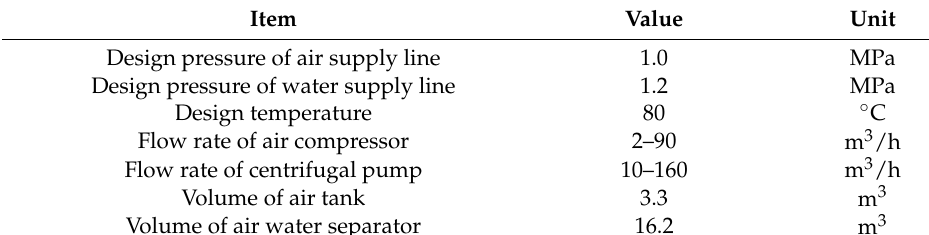
Table 4. Design parameters of the low pressure water loop.